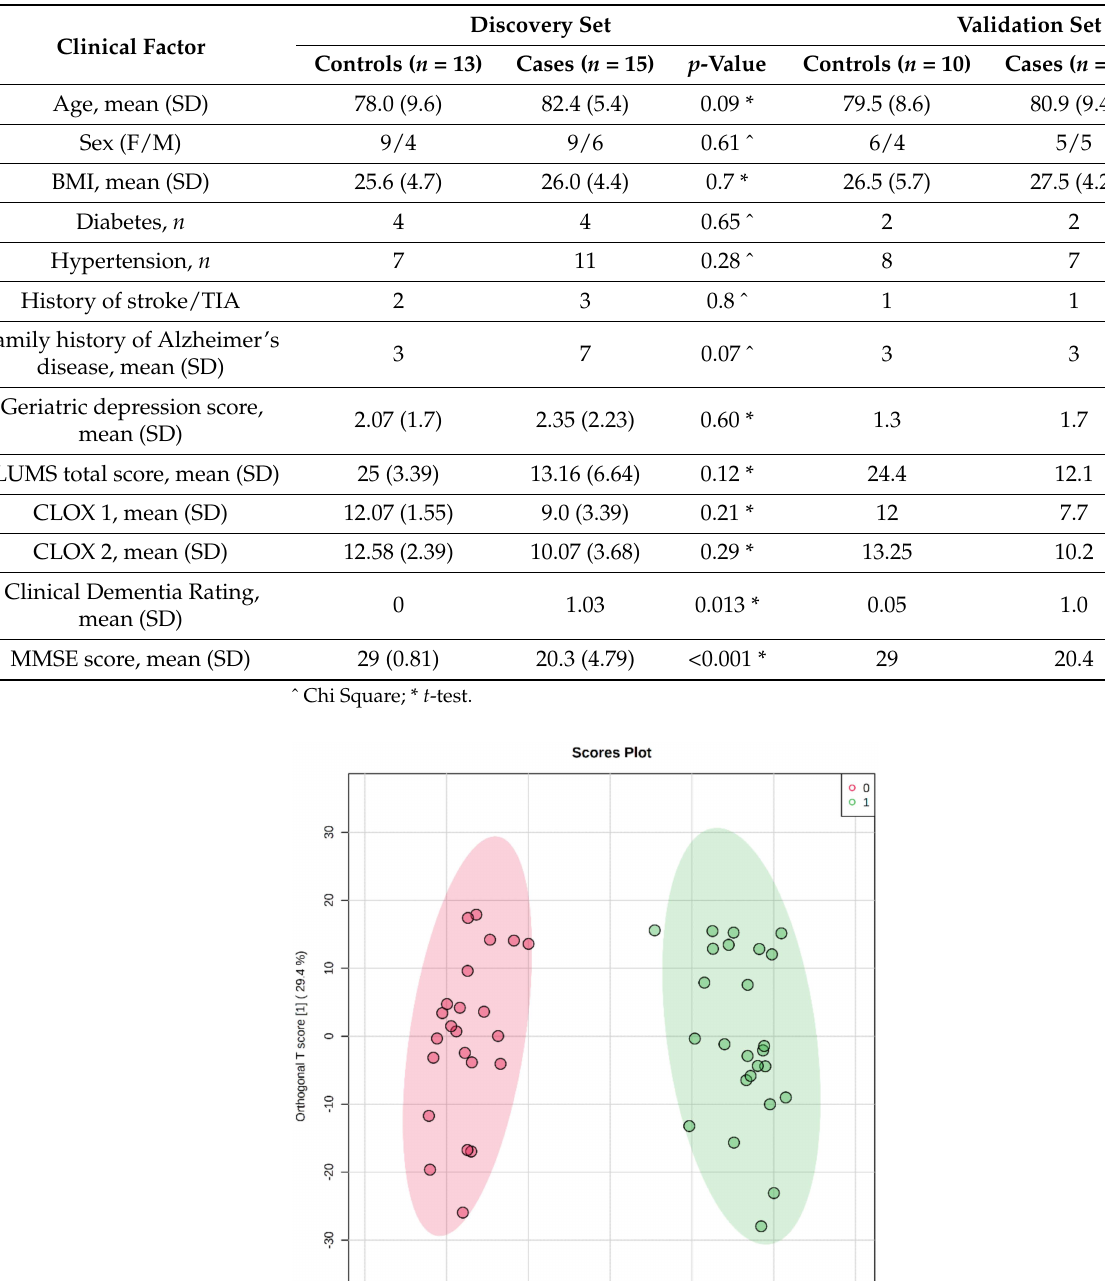
Table 1. Clinical demographics and parameters comparison in discovery and validation groups.